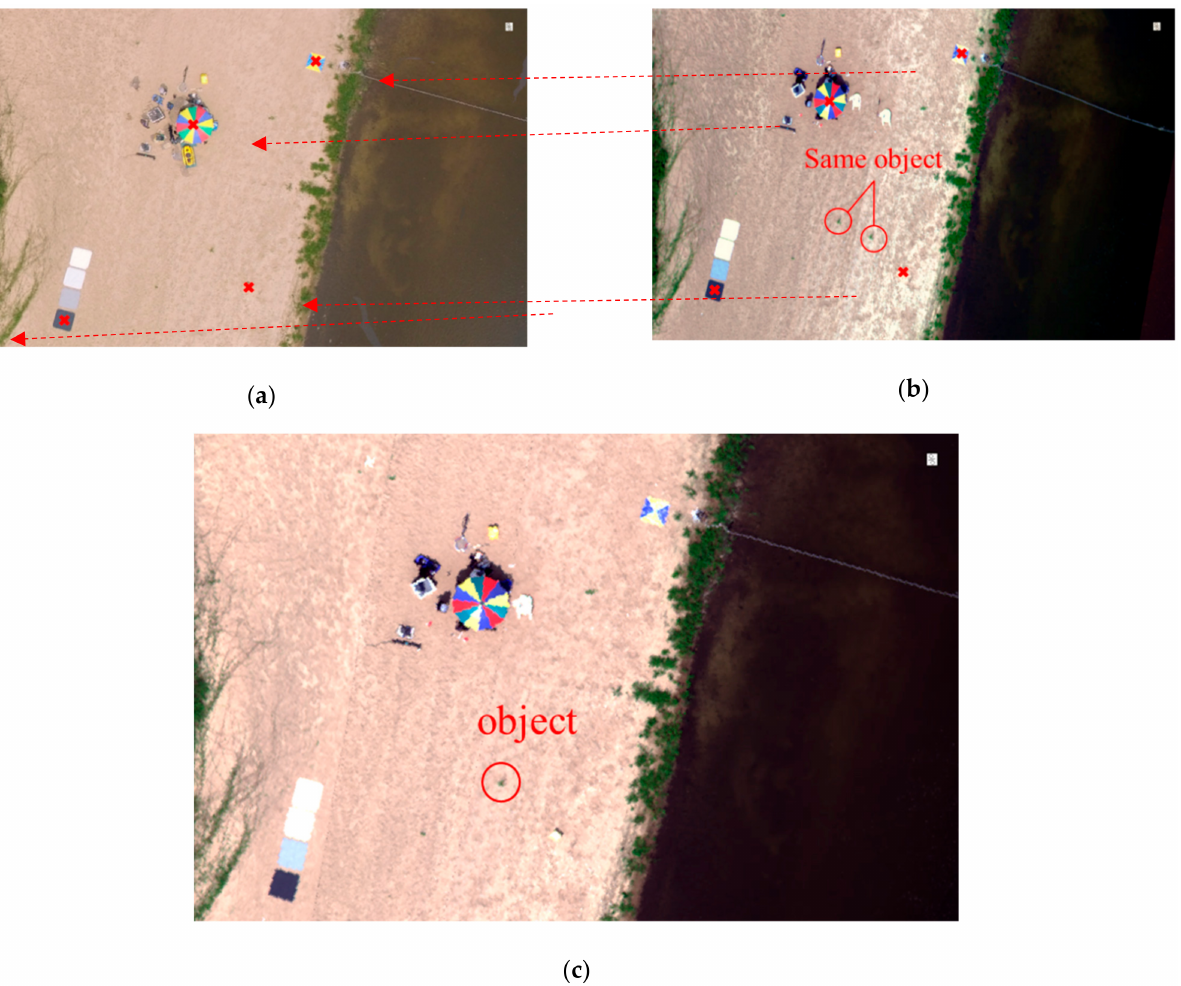
Figure 11. Example of application of the method proposed in this study: ( a ) RGB optical image; ( b ) georeferenced hyperspectral image; ( c ) 2D image transformation of the target image, achieved using the derived